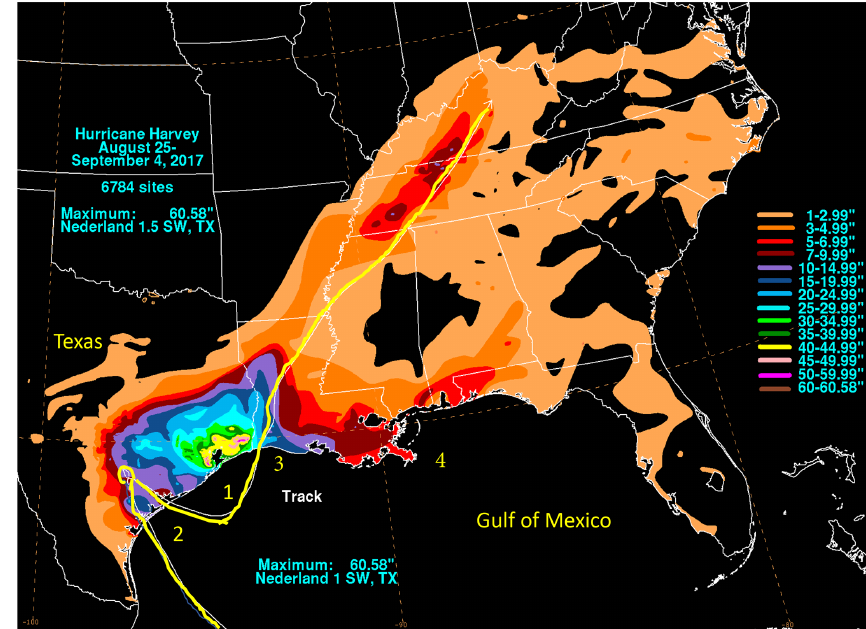
Figure 1. Track of Hurricane Harvey and associated rainfall (in inches) over the southern United States, 24 August–4 September 2017 (from Blake and Zelinsky, 2018, with permission from the NOAA). The numbers 1, 2 and 3 denote the positions of Galveston Bay, Matagorda Bay and Lake Sabine respectively. The Mississippi Delta (in Louisiana) is shown as 4. The Nederland 1.5 SW rain gauge, which recorded the highest rainfall, is at 29.95 ◦ N, 94.01 ◦